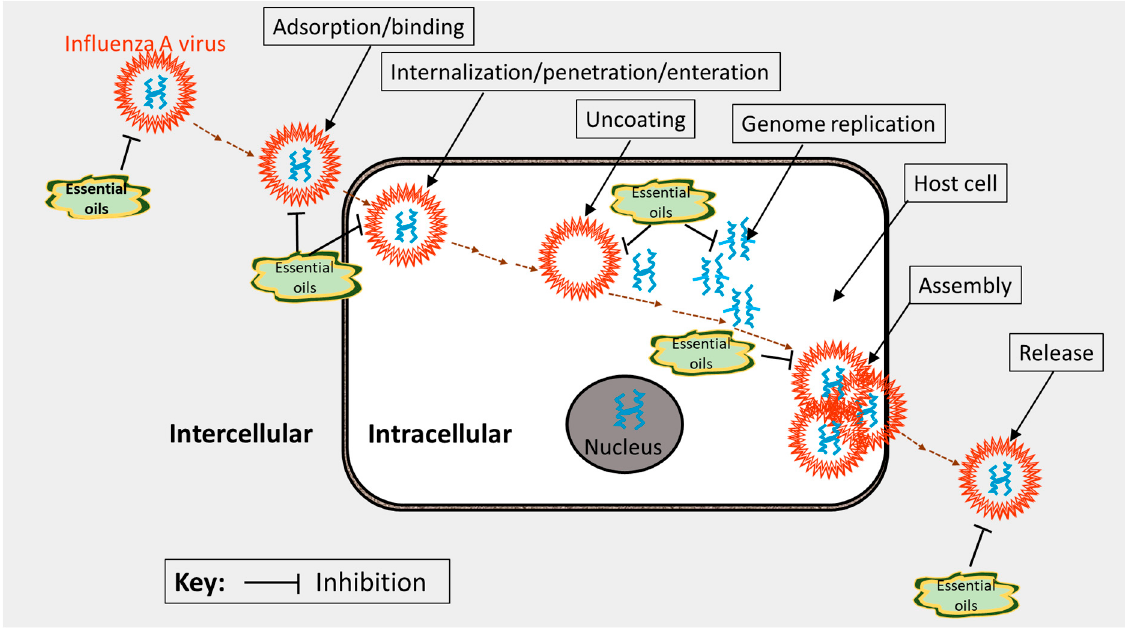
Figure 4. Plausible target sites (mechanisms of action) of essential oils during the influenza virus lifecycle. The illustration was adapted from Ma and Yao [146] and redrawn with copyright permission by ©MDPI, Basel, 2020.